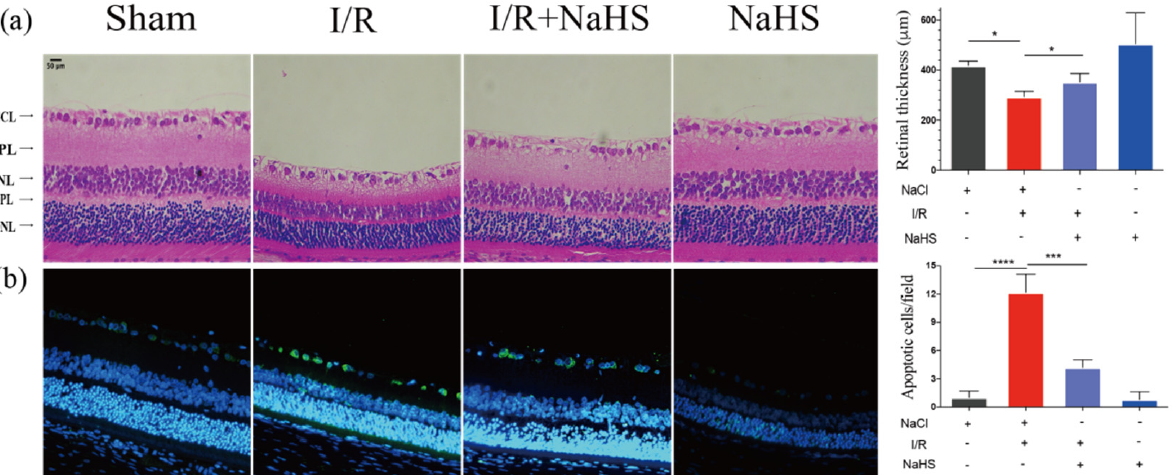
Figure 2. NaHS alleviated I/R-induced retinal neurodegeneration. ( a ) Images of hematoxylin and eosin staining and overall thickness of retinae quantitative analysis. NaHS improved the retinal thinning induced by cerebral I/R. ( b ) Representative images of TUNEL staining and quantitative analysis of TUNEL+ (apoptotic, green) cells. NaHS decreased apoptotic cells in GCL. Scale bar = 50 µ m. Data are presented as the means ± SD, n = 5, * p < 0.05, *** p < 0.001, **** p < 0.0001. Ganglion cell layer—GCL; interplexiform layer—IPL; Inner Nuclear Layer—INL; outer plexiform layer—OPL; outer nuclear layer—ONL.